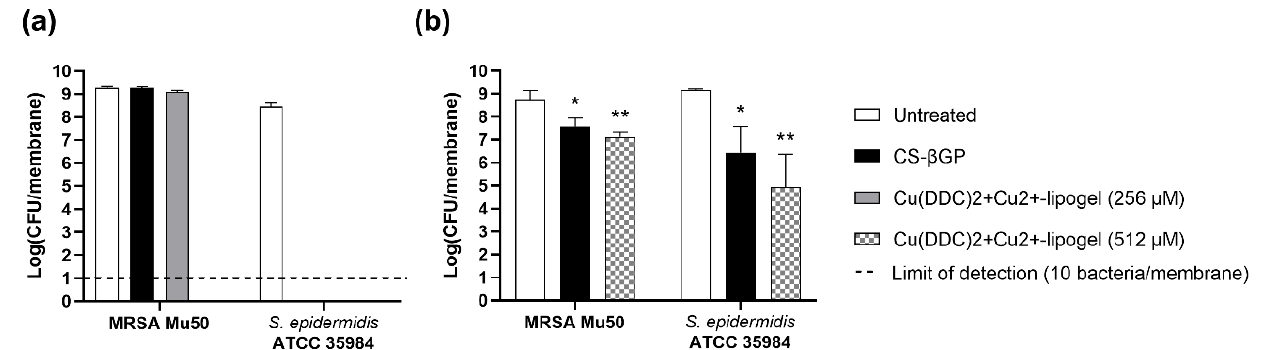
Figure 9. Effect of Cu(DDC) 2 +Cu 2+ -lipogel on colony-forming units (CFUs) of MRSA Mu50 and S. epidermidis ATCC 35984. Log(CFU/membrane) in ( a ) prevention of biofilm formation assay over 2 days and ( b ) biofilm treatment over 4 days. Missing bars represent no bacterial detection (below limit of detection; dashed line). Concentrations of Cu(DDC) 2 -liposomes + Cu 2+ -liposomes correspond to the total Cu 2+ concentration and are based on a 1:6.2 molar ratio of Cu(DDC) 2 -liposomes to Cu 2+ -liposomes. Data are expressed as geometric mean ± standard deviation (n = 3; 1-way ANOVA with Tukey’s mul- tiple comparison test, * p < 0.05, ** p < 0.01). CS- βGP = chitosan with β -glycerophosphate.